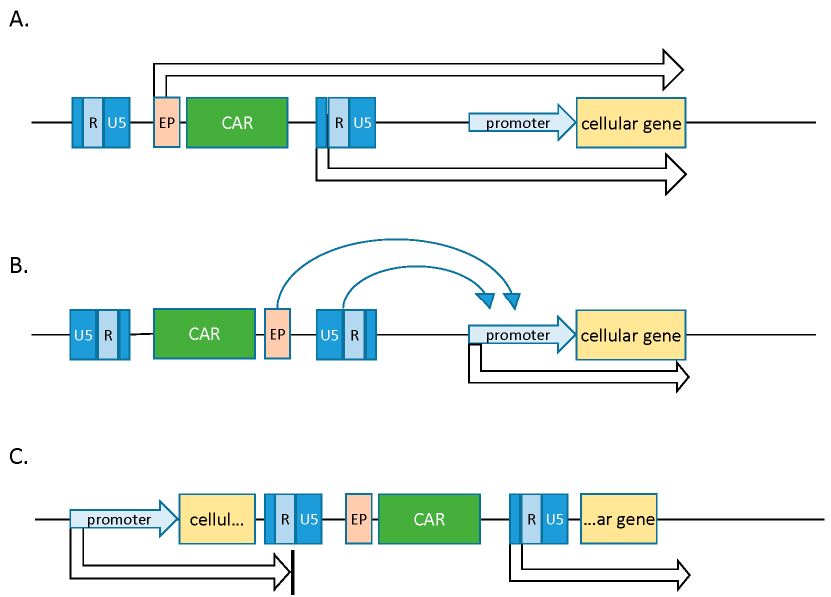
Figure 2. Modes of insertional mutagenesis. ( A ) Promoter insertion—expression of a cellular gene is upregulated when an insertion is upstream and in frame with the cellular ORF (open reading frame). Read-through from either the endogenous promoter or the viral LTR can induce aberrant gene expression. ( B ) Promoter activation—activity of a cellular promoter is influenced by enhancer elements in the viral LTR. This effect is not dependent on orientation or frame agreement and can function at a distance of several kilobases; ( C ) intronic insertions can lead to the production of truncated cellular transcripts. Adapted from Suerth et al. [1].